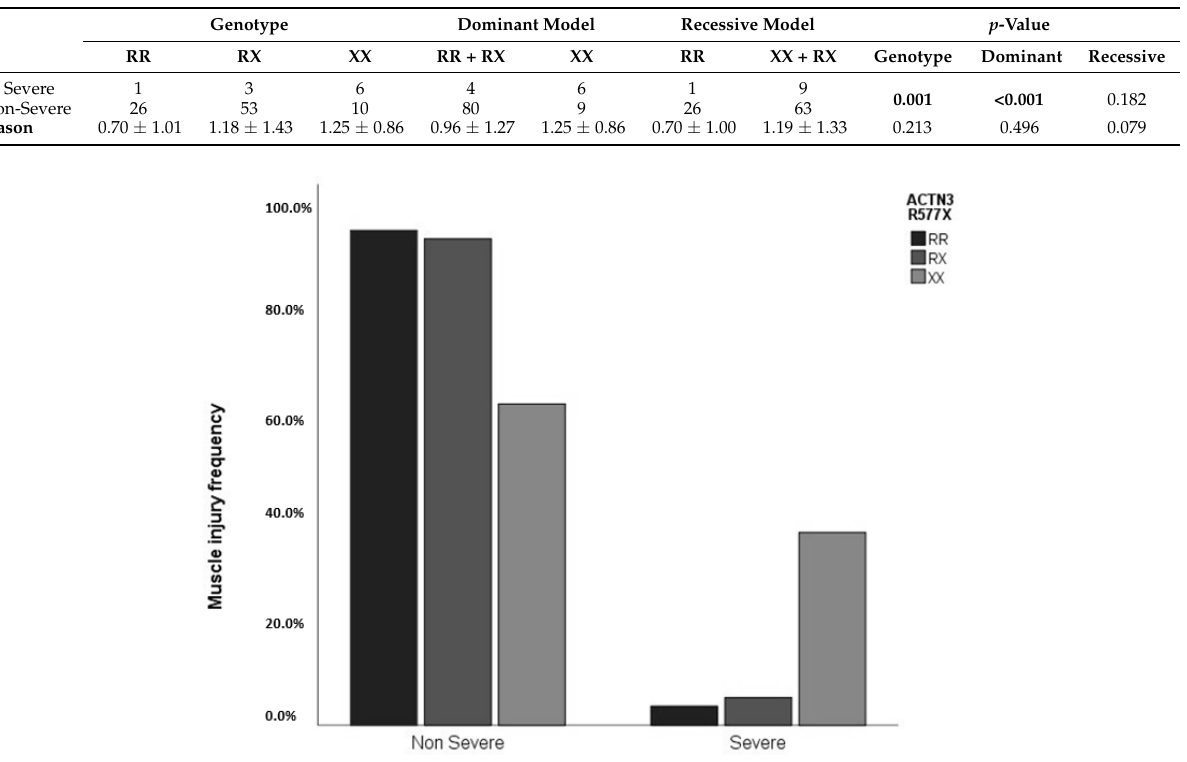
Table 4. Association between the ACE I/D genotypes and severity and incidence of non-contact muscle injury (per season). Genotype